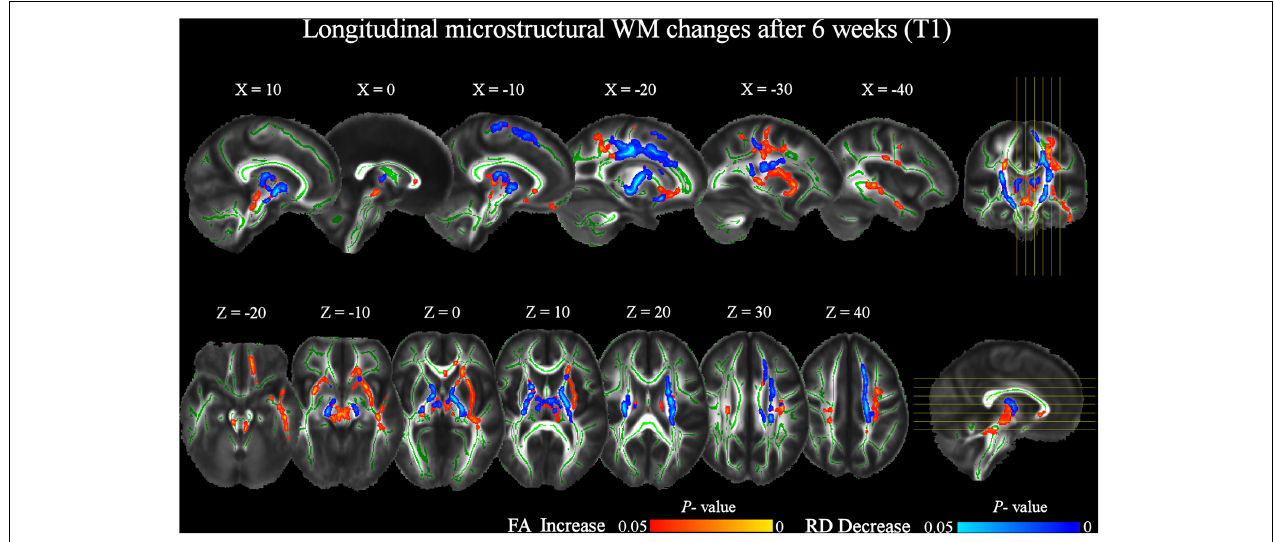
FIGURE 3 | Significant increases in FA and decreases in RD after 6 weeks of daily QMT (T1) respect to T0 baseline (pFWE < 0.05, TFCE corrected). RD changes were investigated in the locations where FA significantly changed. The study-specific FA skeleton, representing the centers of principal WM tracts, is displayed in green, overlaid on the mean FA map. The vertical lines on the coronal view indicate the sagittal slices displayed. The horizontal lines on the sagittal view indicate the axial slices displayed. The red–yellow and blue–light blue color bars represent level of significance for FA increase and RD decrease,